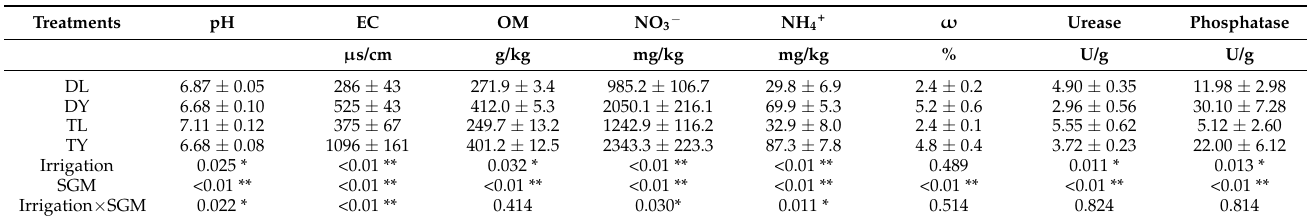
Table 1. Mean values of different treatments in pH, EC, OM, NO 3 − , NH 4+ , ω , urease and neutral